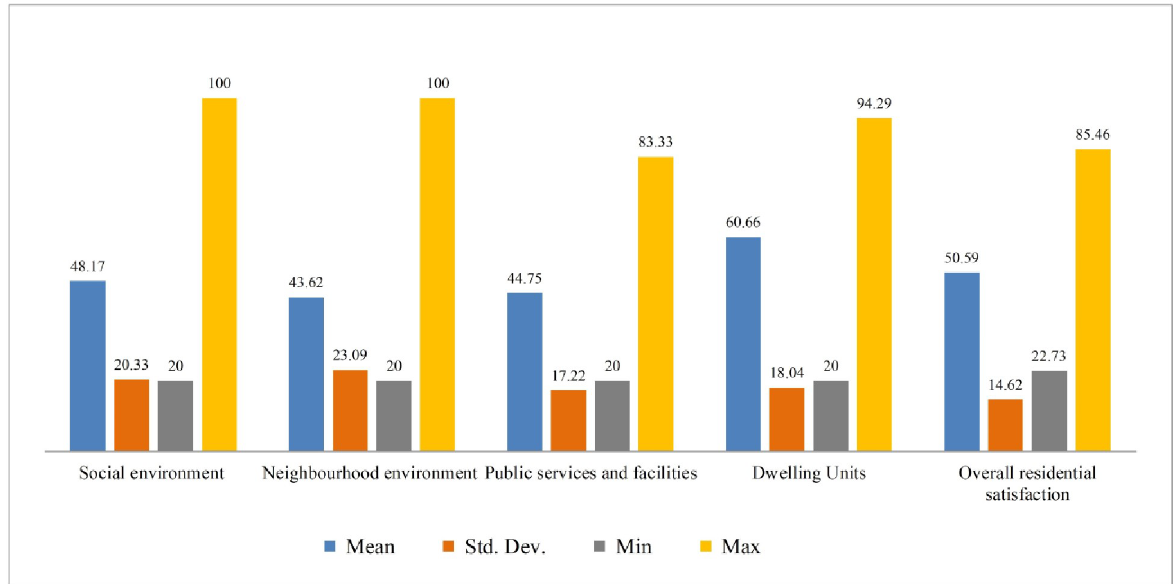
Fig 6. Satisfaction score of four components. Source: Authors’ compilation,